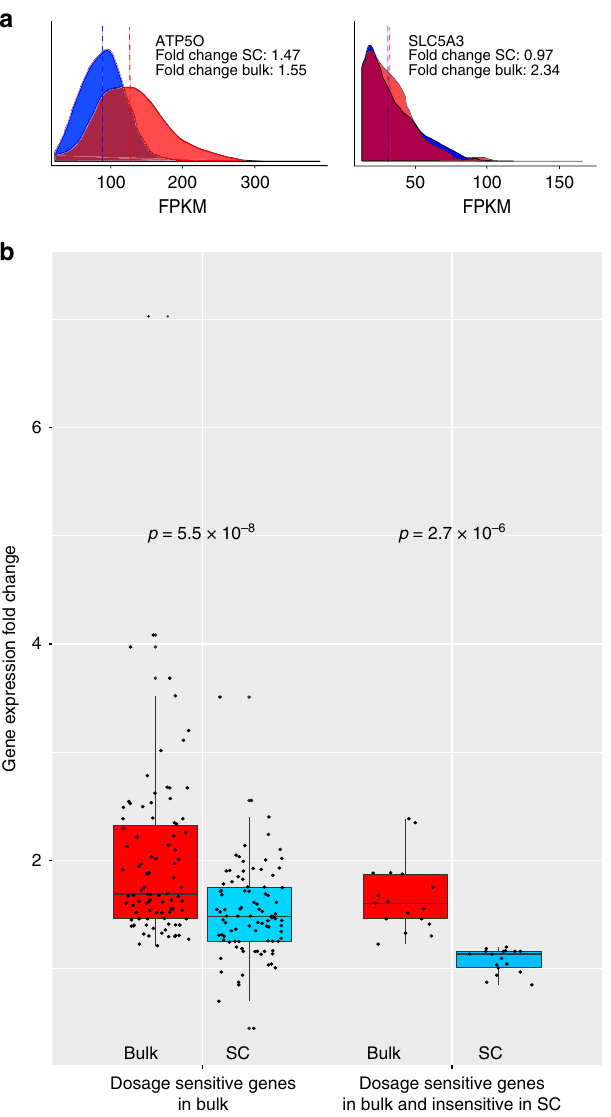
Fig. 4 Fold change expression comparison in bulk and single-cell study. a Left: Distribution of expression levels of ATP5O in diploid (blue) and T21 (red) single cells. The gene presents with the typical trisomy gene dosage effect meanT21/mean = 1.5 as observed in the bulk (FCbulk = 1.5). Right: Distribution of expression levels of SLC5A3 in diploid and T21 single cells. The two distributions are similar and the gene does not present the typical gene dosage effect as observed in the bulk (meanT21/meanD = 1, FC bulk = 2). b Left: Comparison of expression fold change for dosage sensitive genes in the bulk (FC bulk >1.2, 94 genes) and SC of twins discordant for T21. Right: Comparison of expression fold change in bulk and SC for a subset of bulk- dosage sensitive genes presenting with a non-dosage sensitive effect in SCs (insensitive in SC) (0.8< SC FC< 1.2, 17 genes). Boxplot: horizontal lines indicate medians; upper and lower boxes indicate fi rst (25th percentile) and third quartiles (75th percentile); whiskers indicate fi rst quartile — 1.5 IQR (interquantile range = fi rst – third quartile) and third quartile + 1.5 IQR. Source data are provided as Source Data fi le